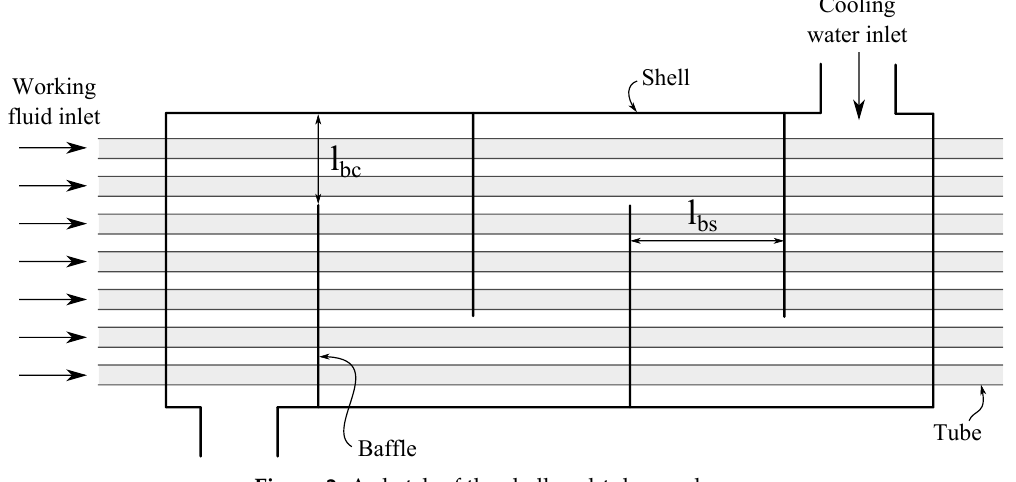
Figure 2. A sketch of the shell-and-tube